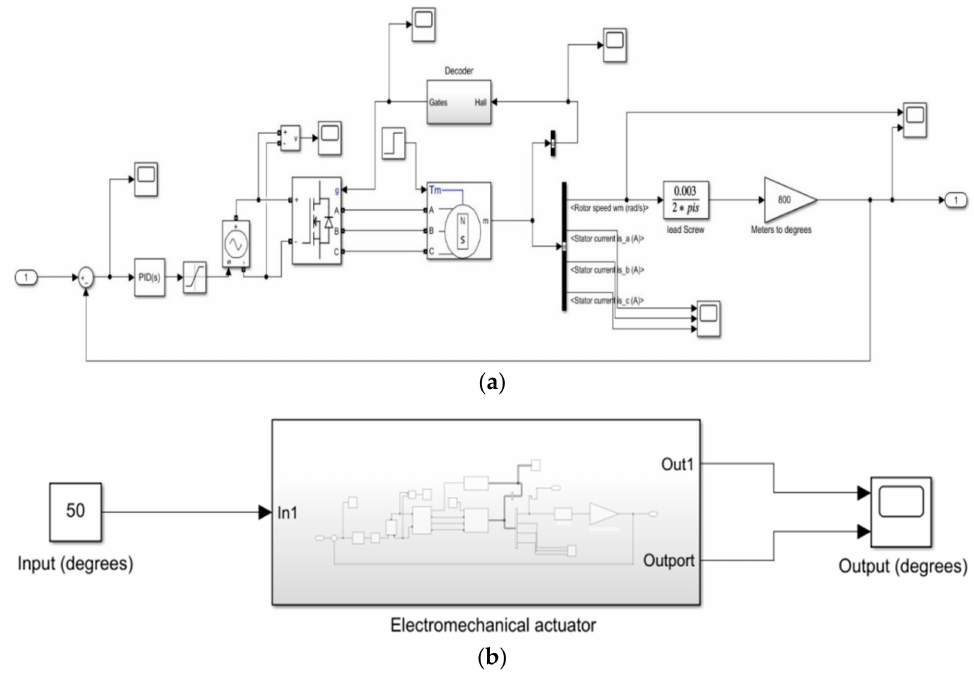
Figure 7. ( a ) EMA system model blocks built for individual components. ( b ) EMA system model blocks were reduced to a subsystem showing input and output responses from built-in